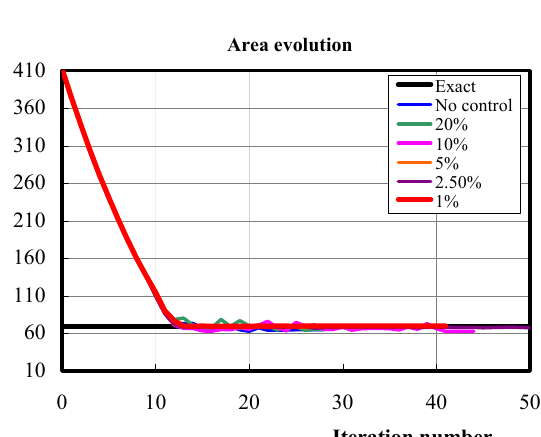
Fig. 5. Influence of γ over the optimal solution found (black contour) and comparison with optimal analytical solution Fig. 7. Deterministic algorithm. Influence of γ over the (shaded area)